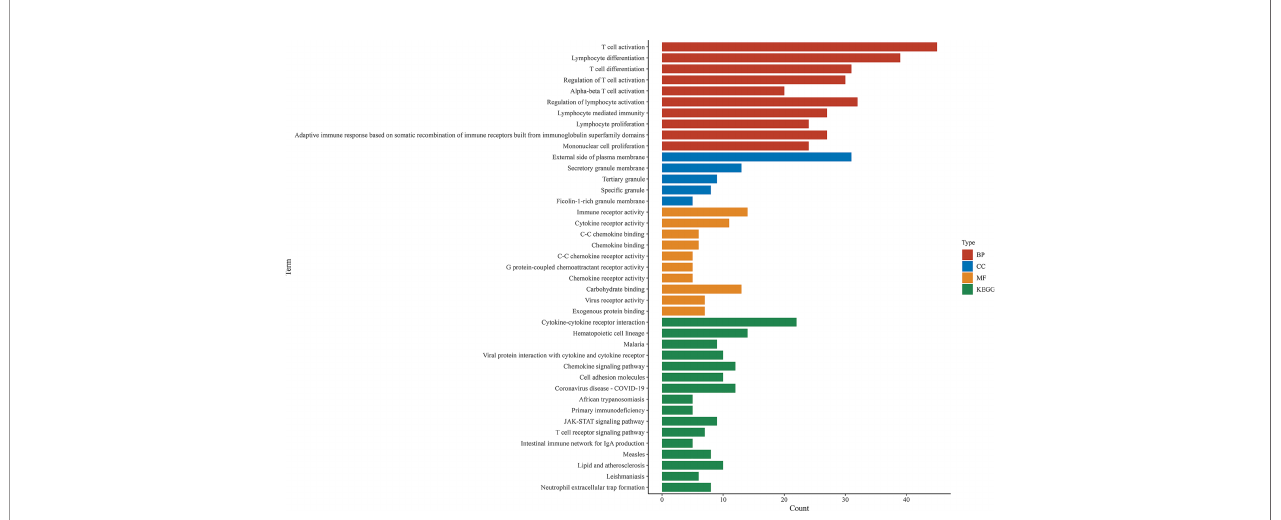
FIGURE 4 | GO and KEGG enrichment analysis among shared DEGs. BP, biological process; CC, cellular component; MF, molecular function.